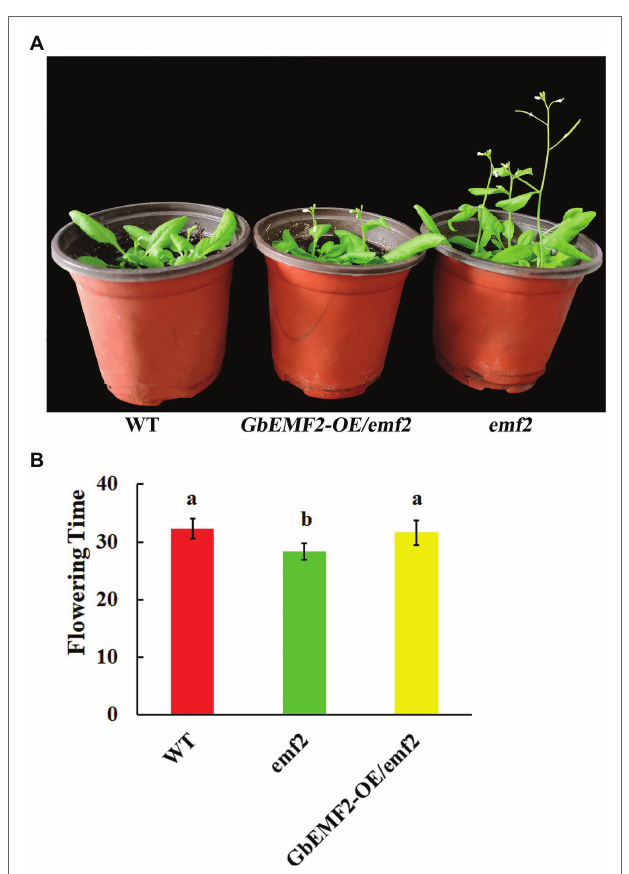
FIGURE 4 | Comparative analysis of the flowering time in GbEMF2-OE/ emf2 , wild-type (WT), and emf2 mutant of Arabidopsis . GbEMF2-OE/ emf2 , T 3 generation of GbEMF2 transgenic Arabidopsis ; WT, wild-type Arabidopsis ; emf2 , Arabidopsis emf2 mutant plants. (A) Comparison of morphological characteristics of the flowering time. (B) Comparison of the days of flowering time of different plants. Each sample has three biological replicates, and data are mean ± SD for three biological replicates, with 10 plants per replicate. Letters mean significant difference at p ≤ 0.05 by the Duncan’s multiple range tests.